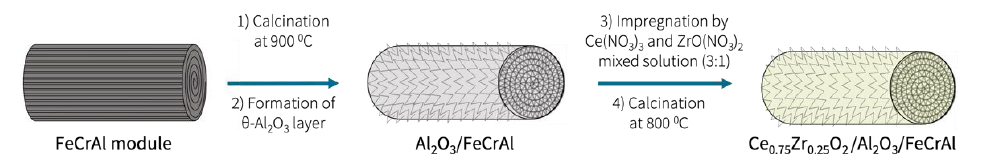
Figure 1. Scheme of the Ce 0.75 Zr 0.25 O 2 /Al 2 O 3 /FeCrAl